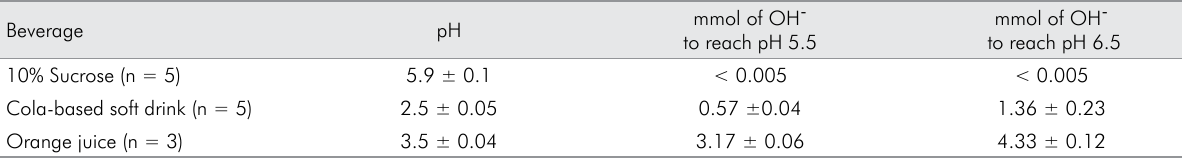
Table 1. Titratable acidity of the tested beverages (average ± standard deviation)